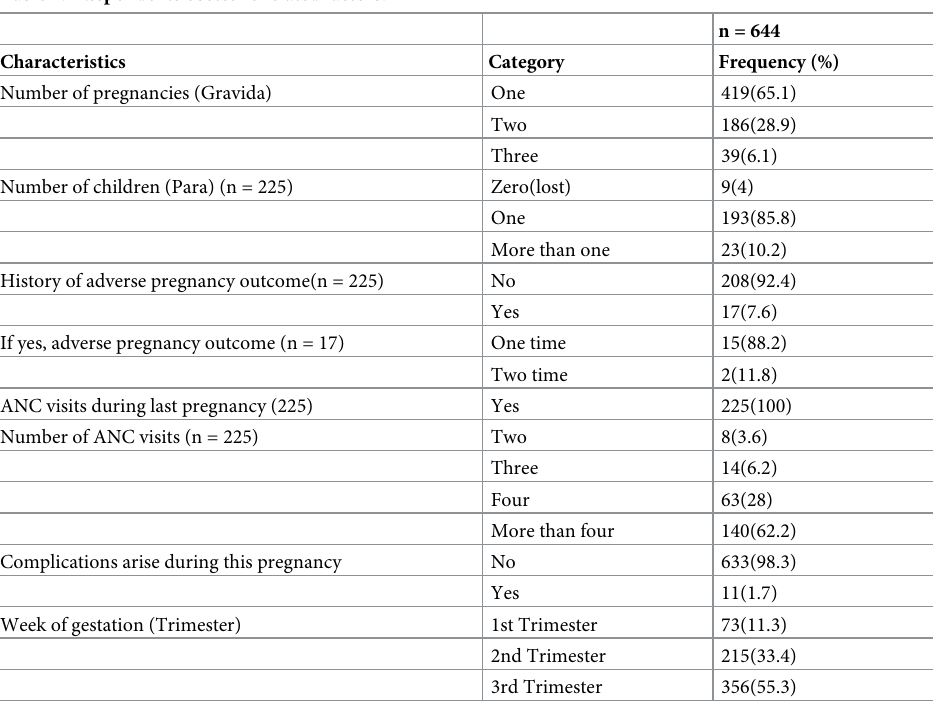
Table 2. Respondents obstetric related factors.